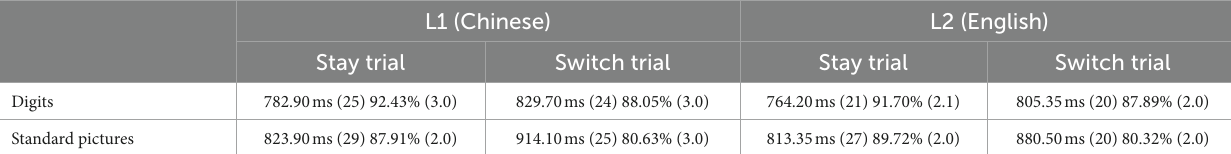
TABLE 1 Reaction times in ms and accuracy rates in percentage (standard deviations in brackets) in the digit naming and standard picture naming.